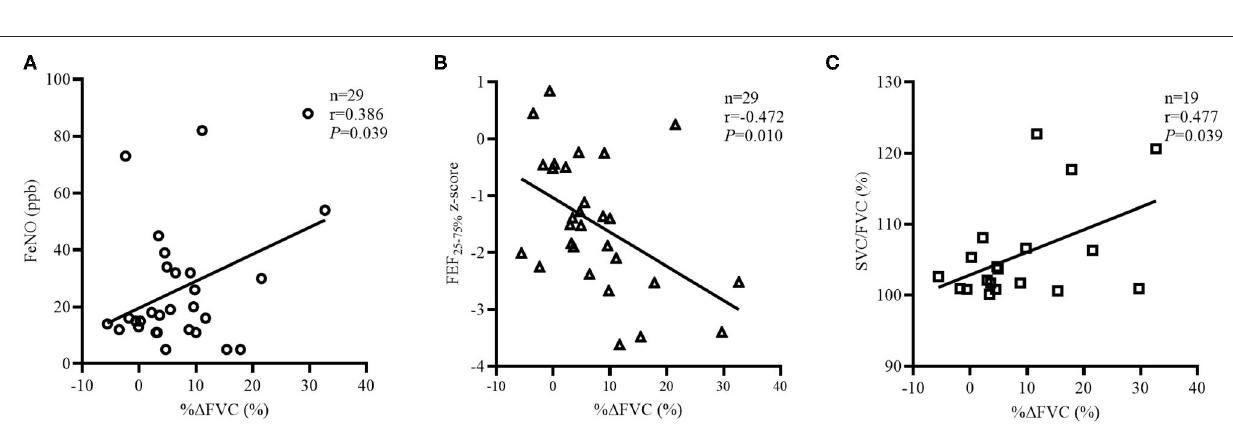
FIGURE 5 | Factors related to % 1 FVC in the “restricted” group with BDTs. The correlation coefficients were obtained by Pearson’s correlation. (A) Changes in FeNO related to % 1 FVC values. (B) Changes FEF 25 − 75 % z-score related to % 1 FVC values. (C) Changes in SVC/FVC (%) related to % 1 FVC